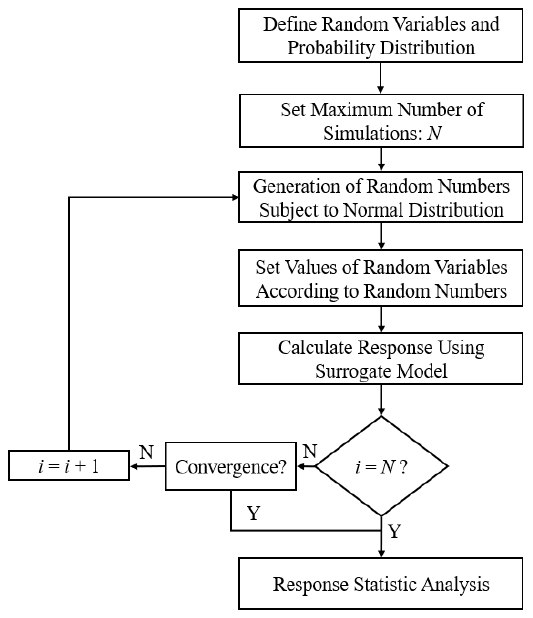
Figure 1. Flowchart of MCS calculation.